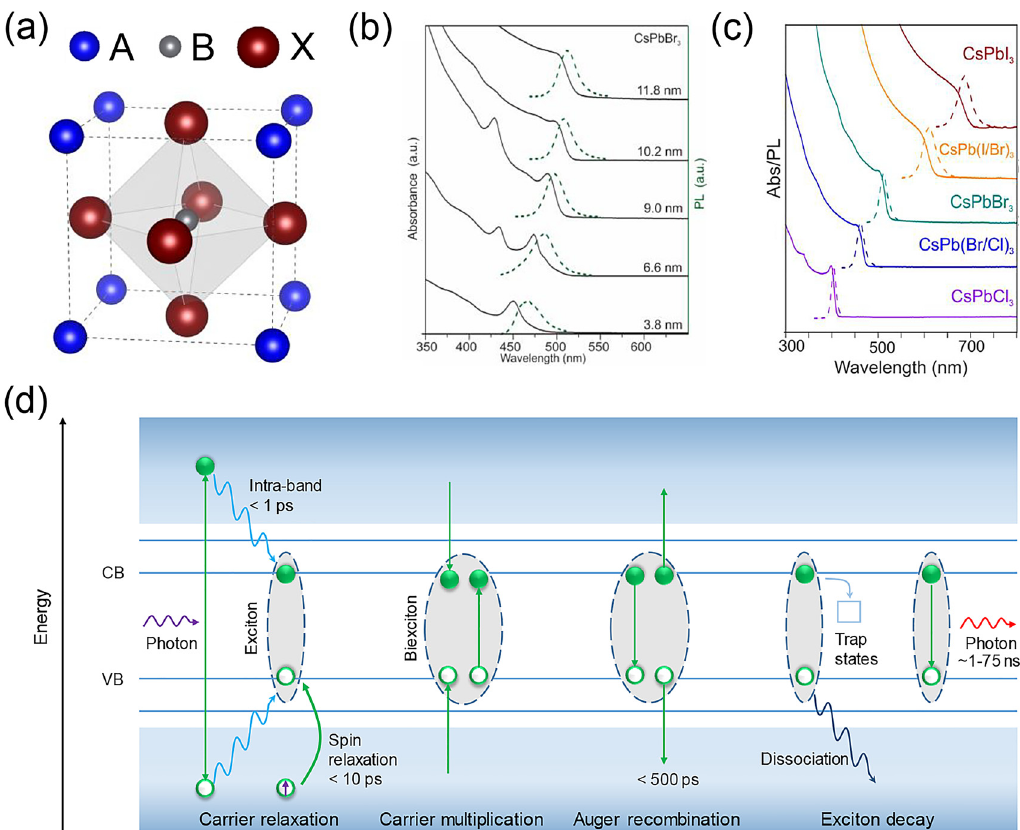
Figure 1: (a) Schematicdiagramof the perovskite semiconductor with ABX 3 structure, where A is anorganic or alkali-metal cations(e.g.,MA + , FA + or Cs + ), B is a divalent cation (e.g., Pb 2 + ) and X is a halide anion (e.g., Cl − , Br − or I − ). (b) Absorption and PL spectra of CsPbBr 3